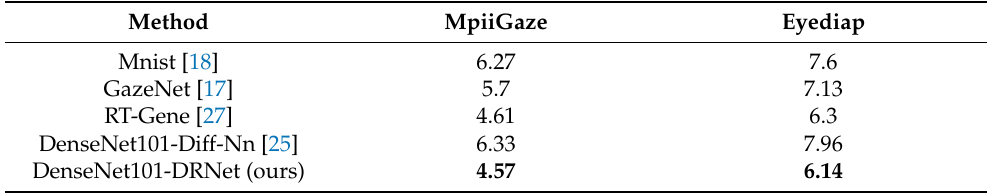
Table 1. Performance summary ( angular-error ) and comparison with recent works using eye features.